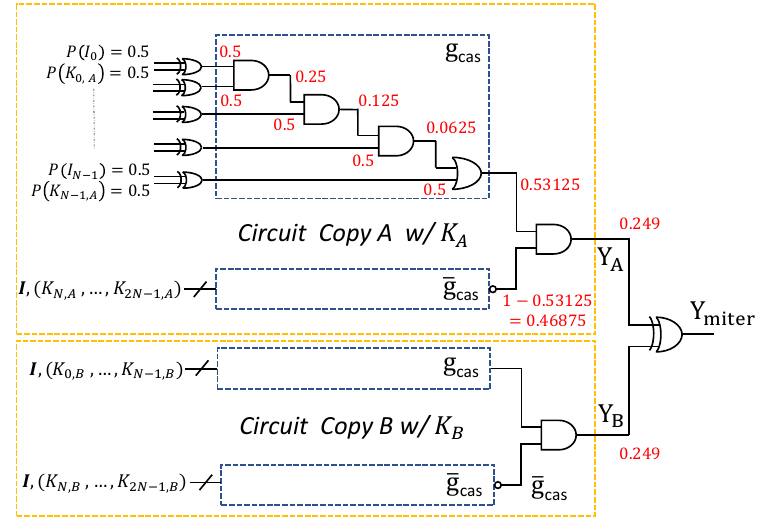
Figure 10: Miter circuit used for bypass attack and corresponding probabilities of logic-1 at various